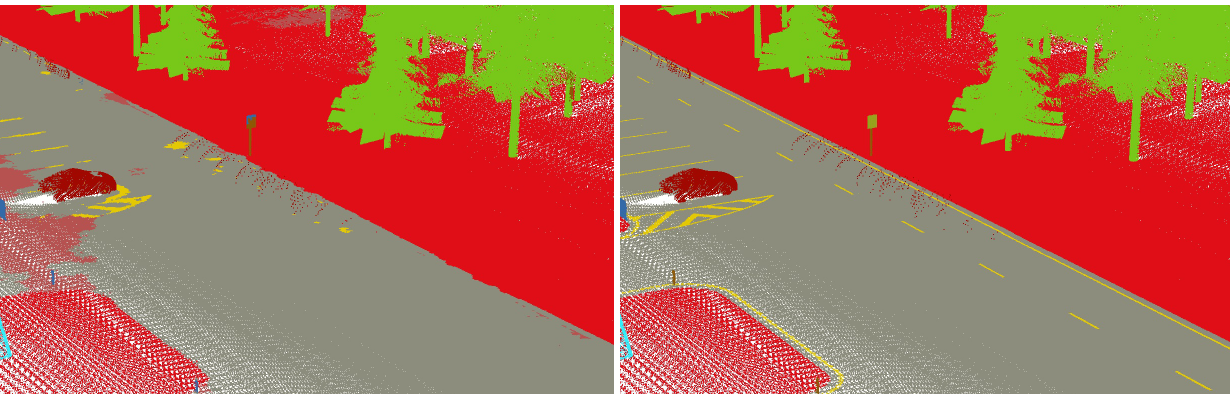
Figure 6. Left , prediction in T 7 test set of CARLA data using KPConv model. Right , ground truth.